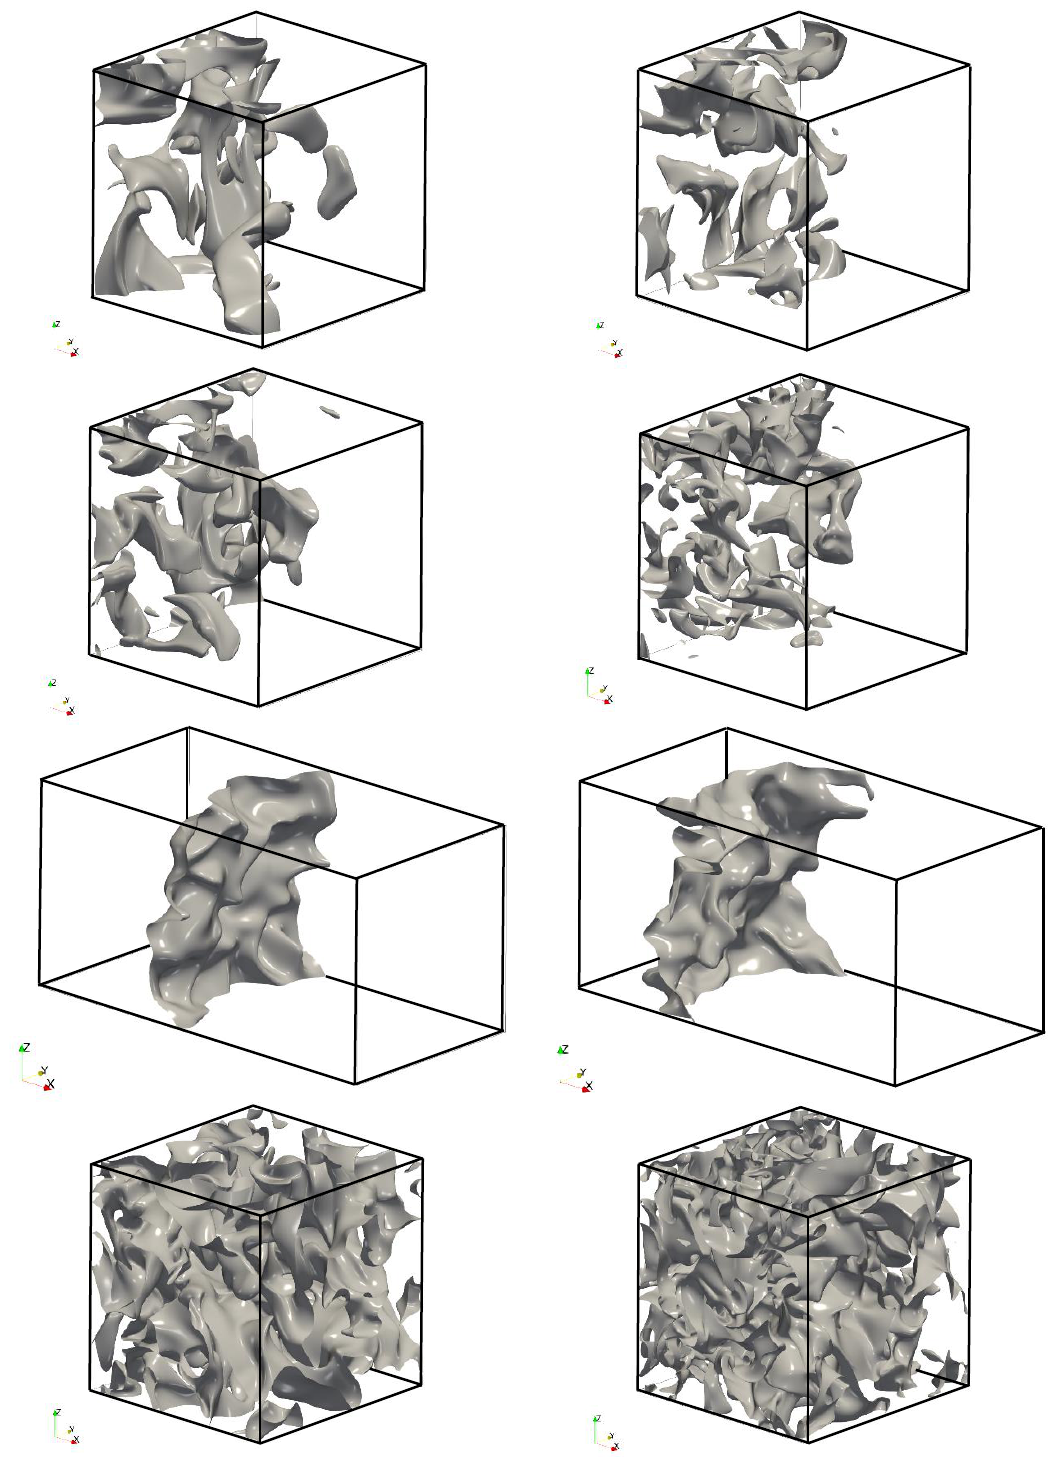
Figure 1. Instantaneous views of 𝑐 = 0.5 isosurface for homogeneous mixture MILD combustion with 3.5% and 4.8% O 2 concentration (1 st and 2 nd row), premixed combustion (3 rd row) and passive scalar mixing (4 th row) for initial 𝑢 ′ /𝑆 𝐿 = 4.0 (1 st column) and 8.0 (2 nd column).